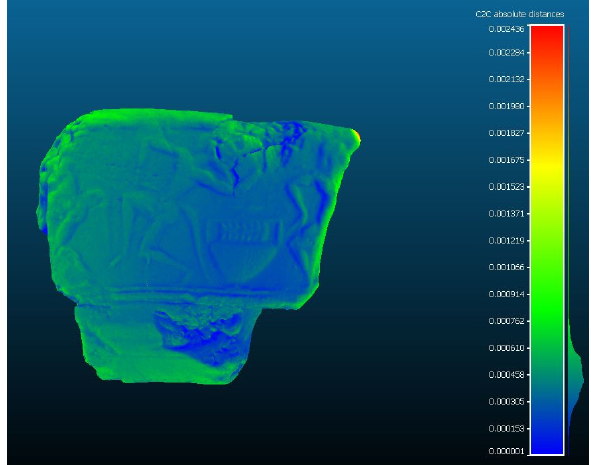
Figure 11. Cloud-to-cloud distance between dense point clouds of the fragment with Komòs scene.